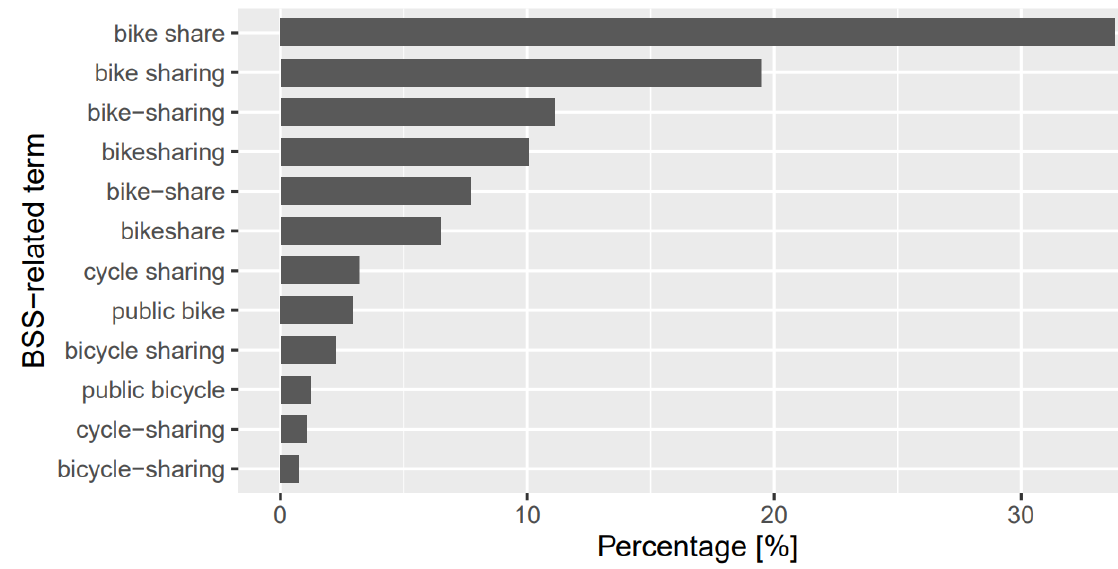
Figure 2. Relative frequencies of BSS-related terms in the collected tweets